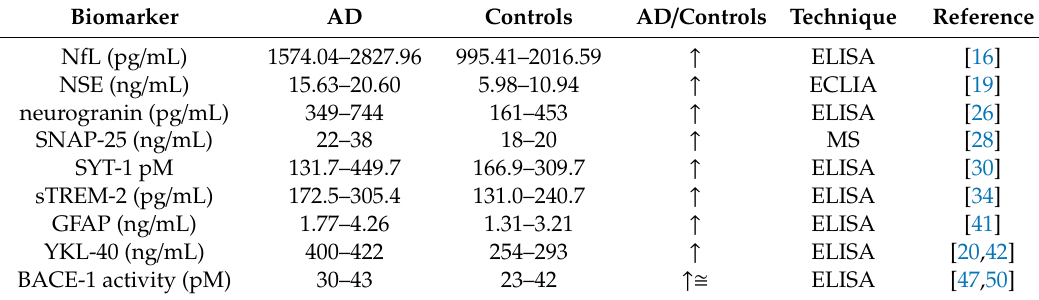
Table 1. Changes in levels of CSF biomarkers in Alzheimer’s disease (AD) patients and